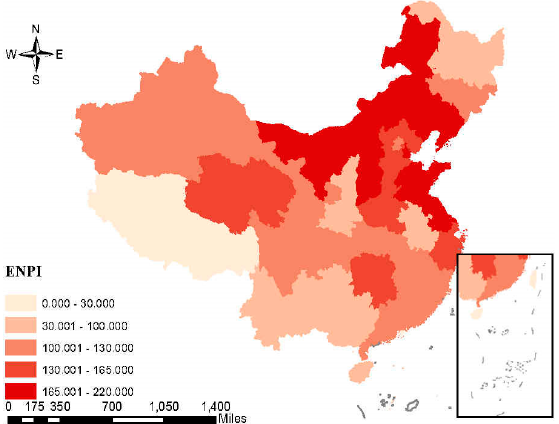
Figure 5. The spatial distribution of average annual proportion of the employees in population (ENIP) of six polluting industries in China. Source: Calculated by the authors on the basis of statistical yearbooks of 31 provinces, 2005–2015.